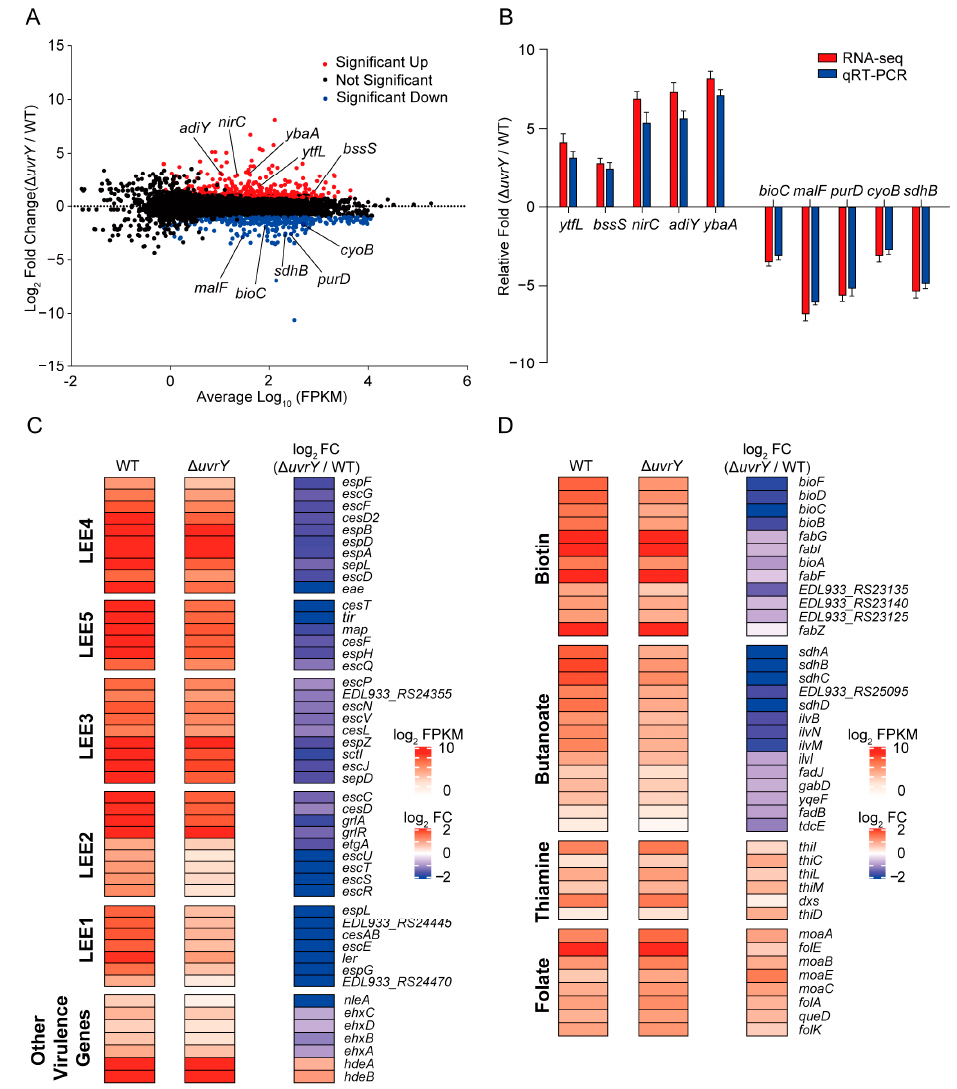
Figure 5. Transcriptome analysis of uvrY deletion measured using RNA-seq. ( A ) A MA plot showing all the differential expression genes between the WT and ∆ uvrY strains cultured in DMEM. Each dot denotes one gene. Red dots represent upregulation genes ( p ≤ 0.05, log 2 foldchange ≥ 1), and downregulated genes ( p ≤ 0.05, log 2 foldchange ≤ − 1) are marked with blue color. ( B ) A bar plot showing the qRT-PCR result of the ten randomly selected DEG genes in ∆ uvrY compared with WT marked in ( A ), ( n = 3). ( C ) A box plot showing LEE genes, nleA , ehxCABD operon, and hdeA / hdeB gene expression level in ∆ uvrY compared with WT. ( D ) Box plots showing the expression changes in the biotin, butanoate, thiamine, and folate metabolism gene sets in ∆ uvrY compared with the WT strain captured from the RNA-seq profile.